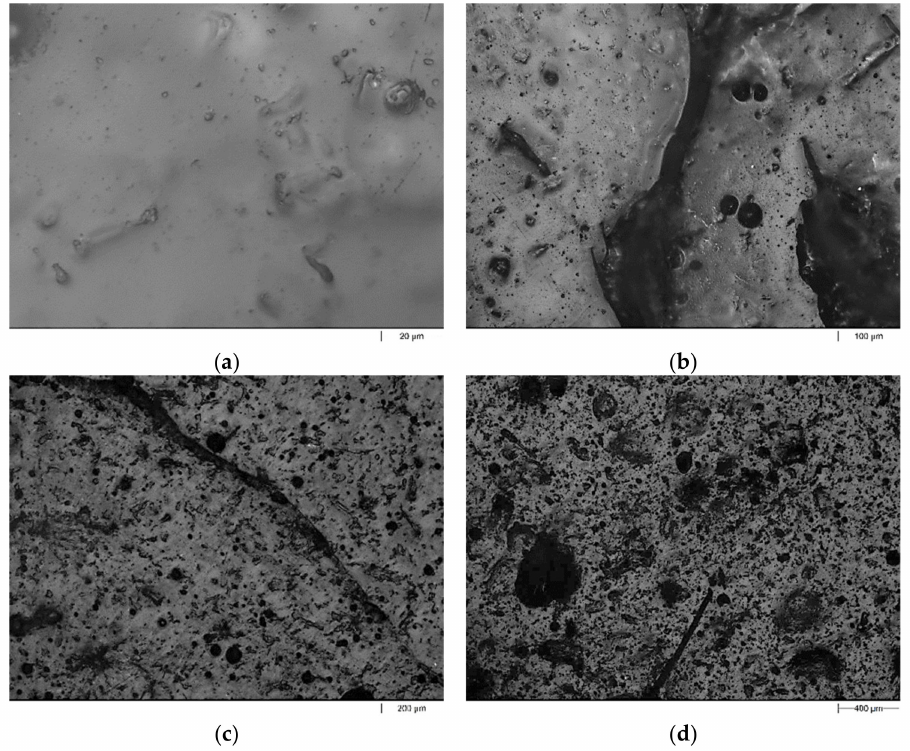
Figure 10. Morphologi 3G microscope images of the UPR + 30 composite before ( a ) and after ( b – d ) the immersion test. ( a ) Reference sample; ( b ) CH 3 COCH 3 ; ( c ) NaOH; ( d ) Na 2 CO 3